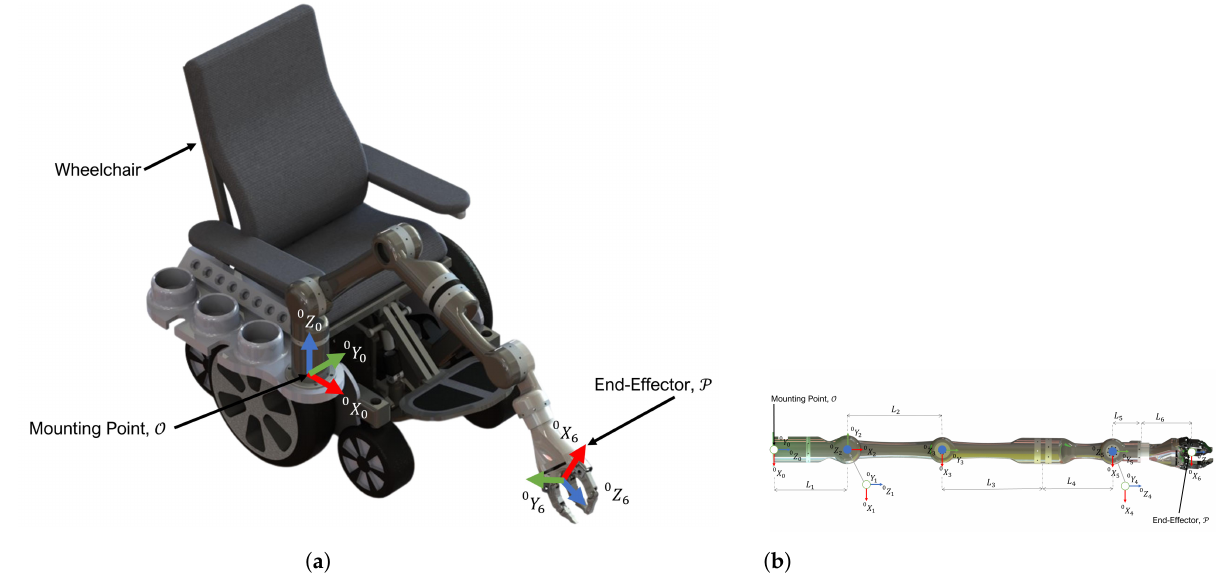
Figure 1. Wheelchair-mounted assistive robot. ( a ) CAD, ( b ) Joint Coordinate Definition. Table 1. DH Parameters of the Assistive